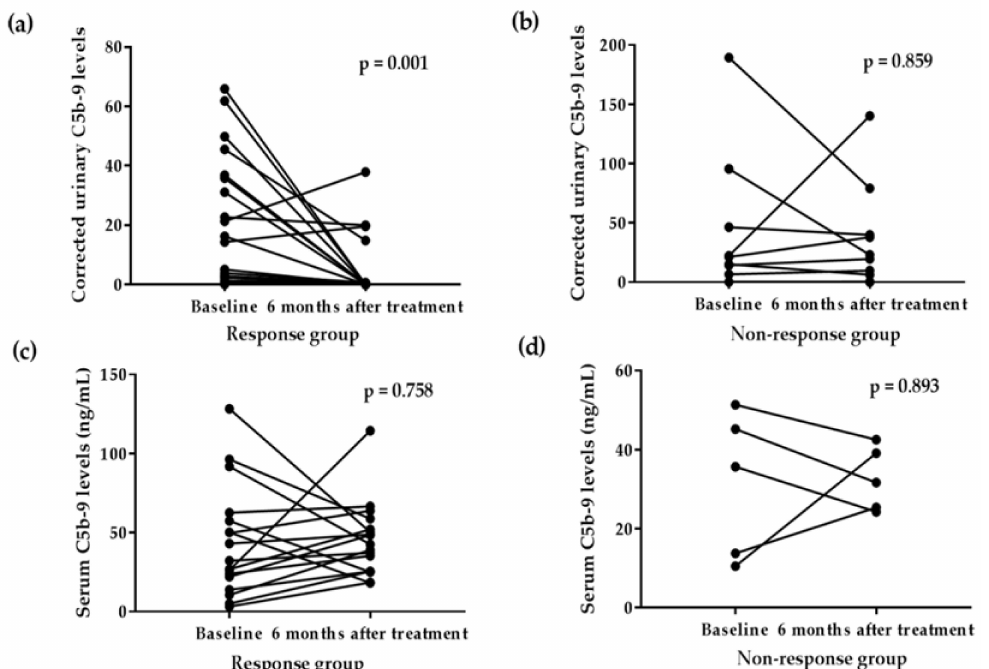
Figure 2. Changes in serum and urinary levels complement C5b-9 levels in response and non- response group at 6 months after medical treatment. While corrected urinary C5b-9 levels decreased in the response group ( a ) but did not in the non-response group ( b ). Serum C5b-9 levels did not decrease in both response ( c ) and non-response group ( d ). The response group was defined as proteinuria < 0.3 g per 24 h or a decrease in proteinuria by at least 50% from the initial value and <3.5 g per 24 h at 6 months after medical treatment. Data were analyzed by Wilcoxon matched-pairs signed-rank tests.